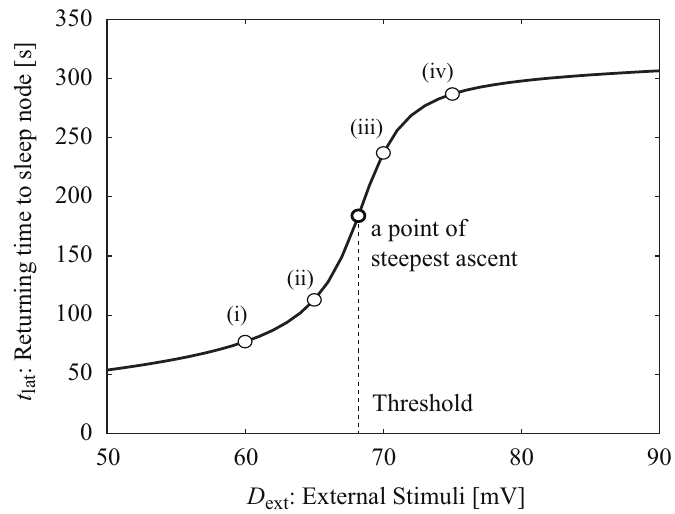
Figure 3. Relationship between the time to return to the sleep node, t lat , and the strength of the external stimulus, D ext . The neuroelectrical threshold of awakening, D ˚ return time ascent is the